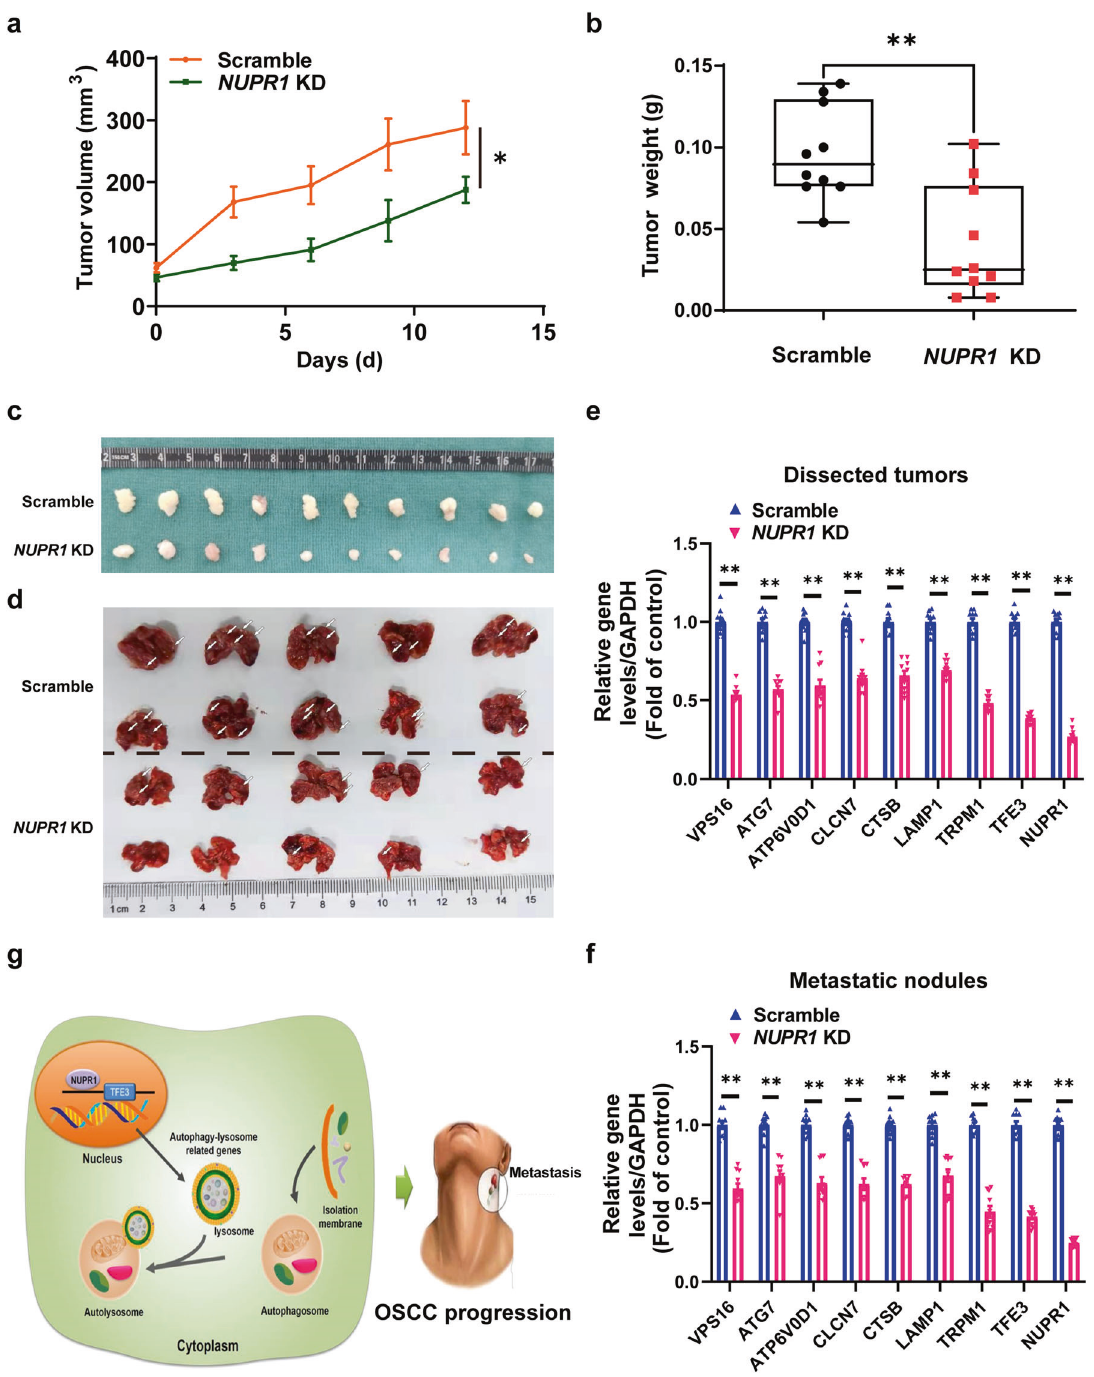
Fig. 6 NUPR1 KD inhibited aggressiveness of OSCC in nude mice. a , b Calculated volume and weight of xenograft tumours generated by NUPR1 KD or scrambled Cal27 cells subcutaneously inoculated into mice. n = 10. c Dissected tumours were photographed. n = 10. d Typical lung tissues with observable metastatic nodules from nude mice after tail vein injection of NUPR1 KD or scrambled Cal27 cells. n = 10. e , f The expression of TFE3 -responsive genes involved in autophagic fl ux was detected by real-time PCR in dissected tumours or metastatic nodules of lung tissues; n = 10. * P < 0.05, ** P < 0.01 versus the scrambled group. g Schematic diagram illustrating the underlaying molecular mechanisms of NUPR1/TFE3 axis-mediated autophagic fl ux in OSCC was markedly decreased following NUPR1 KD and that TFE3 indicates that TFE3-dependent autophagy – lysosome activation is overexpression antagonised the inhibition of lysosome function required for lysosomal function and maintains pH, which caused by NUPR1 KD in OSCC cells. NUPR1 can directly regulate signi fi cantly promote the progression of cancers such as renal genes transcription by combining with platelet-derived growth cancer, pancreatic cancer, and epithelioid haemangioendothe- factor subunit A (PDGFA), synaptosomal-associated protein 25 lioma. 18,32 Interestingly, our data indicated that TFE3 expression